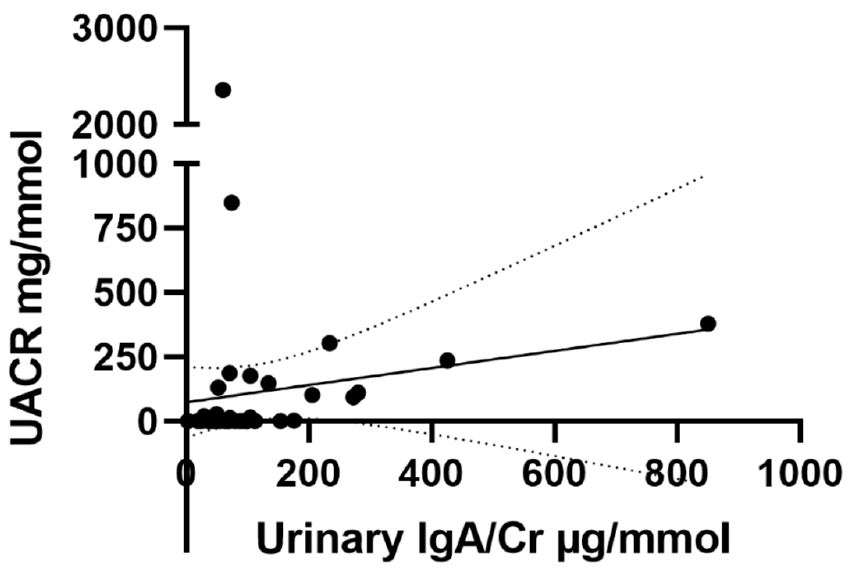
Figure 2. Correlation between urinary IgA/Cr and UACR in patients with IgAV with a linear regression best fit line (r = 0.124; p = 0.407) and 95% confidence bands. UACR: urinary albumin to creatinine ratio.